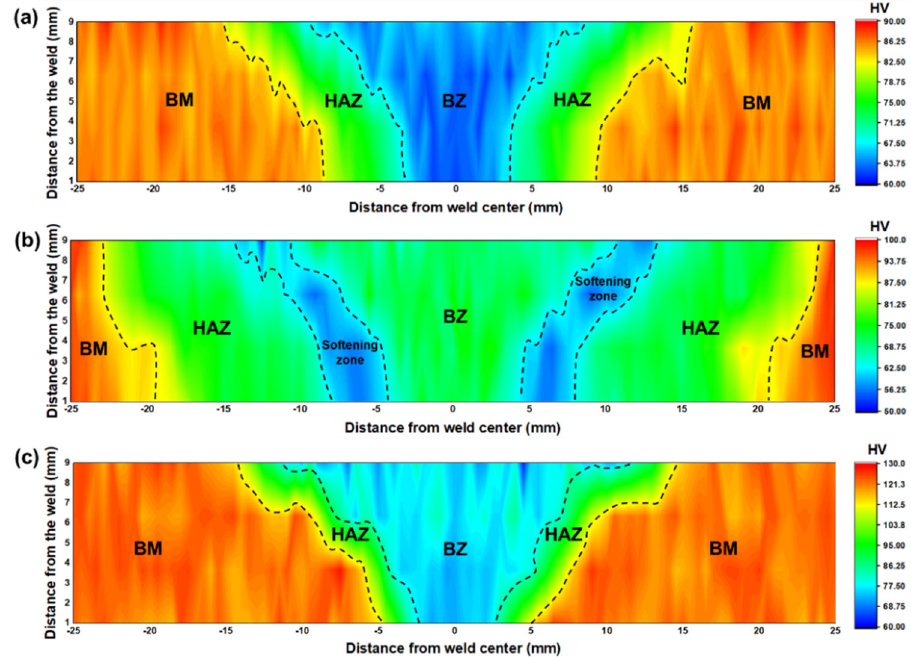
Figure 11. Microhardness profile of different aluminum alloy welded joints: ( a ) 5083; ( b ) 6005A; ( c ) 7N01.